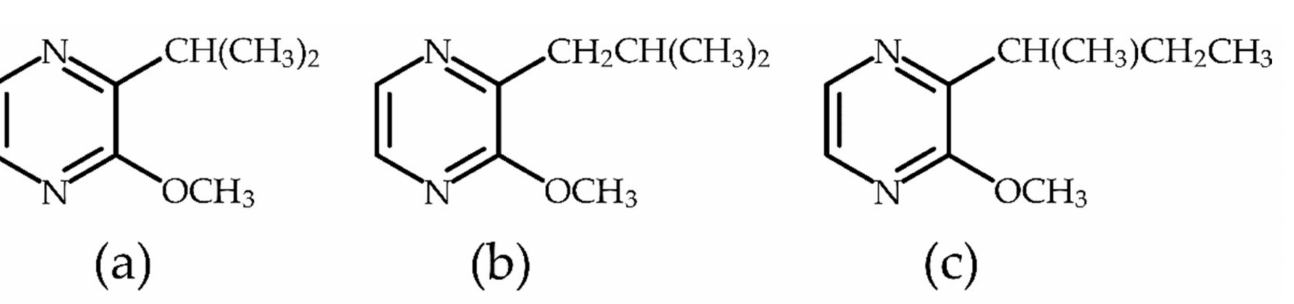
Figure 1. Methoxypyrazines in Sauvignon Blanc grapes and wine. ( a )